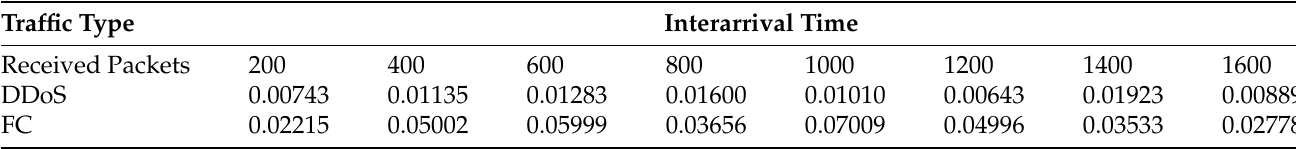
Table 4. DDoS attack versus FC based on